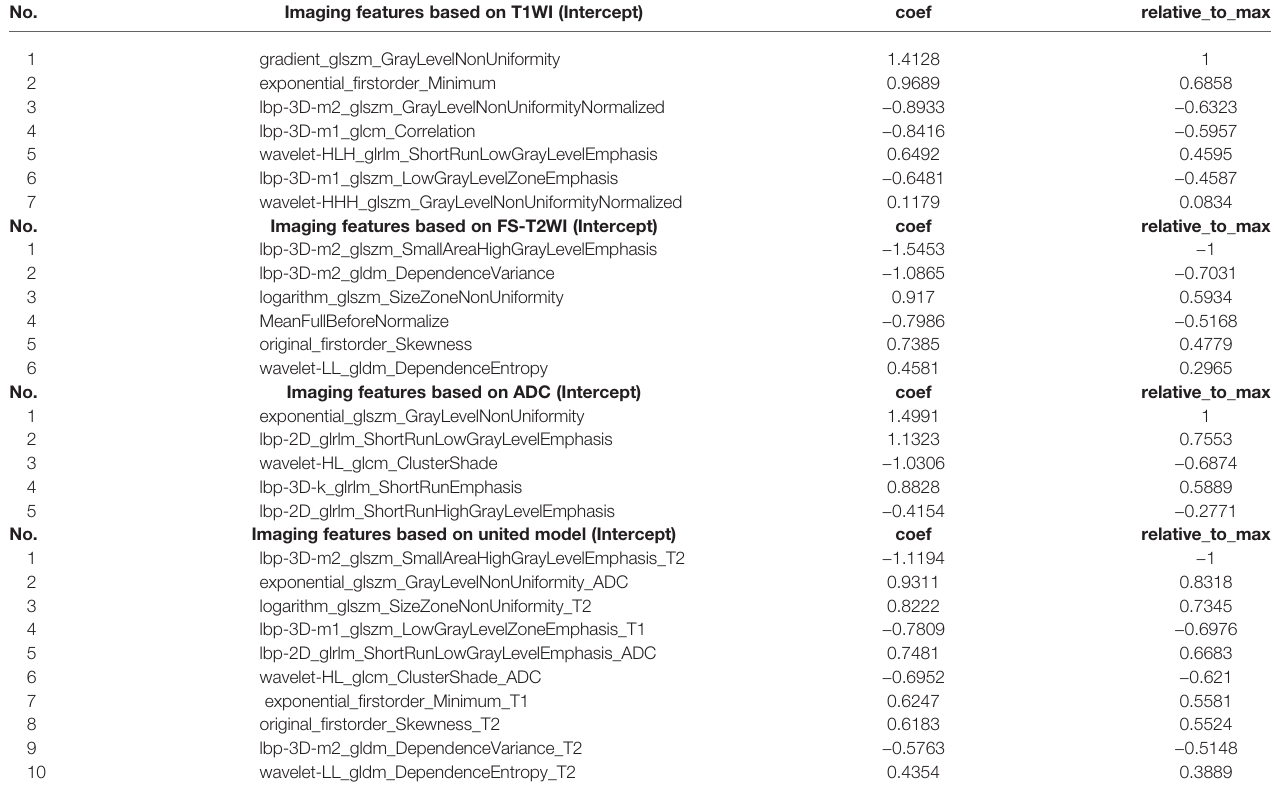
TABLE 2 | The imaging features based on T1WI, FS-T2WI, ADC, and united model. No.